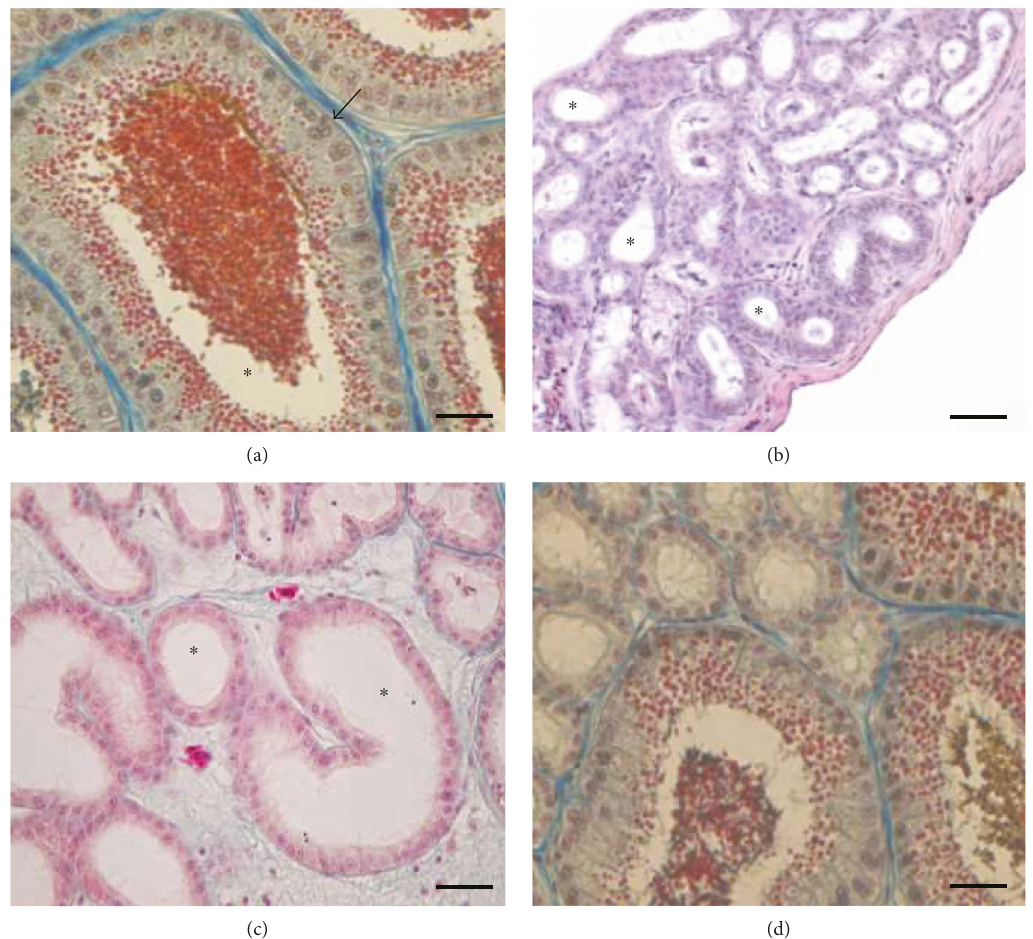
Figure 2: Histology of P. sicula epididymis. (a) Untreated males, mating period: the epithelium of the corpus is elongated and secreting and a large amount of granules is evident inside the lumen ( ∗ ). (b) Clomiphene-treated samples: the cells of the corpus are not secreting; in the lumen, no spermatozoa and secretory granules are evident ( ∗ ). (c) FSH-treated samples: in the lumen of the corpus , no granules and spermatozoa are evident ( ∗ ). (d) FSH-Clomiphene-treated samples: the cells lining the corpus are secreting and some granules and spermatozoa are evident in the lumen ( ∗ ). The bar is 30 μ